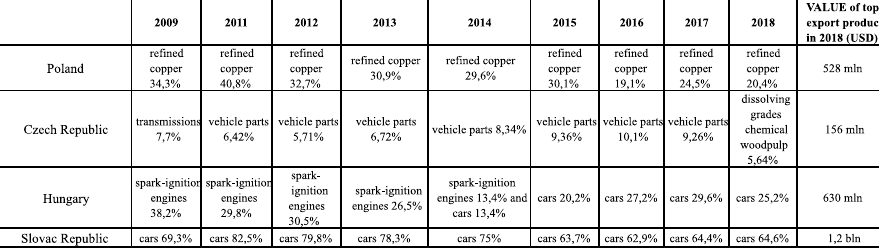
Source: Own elaboration based on OEC, 2020. Top import product of V4 in years 2009–2018, % of import from China